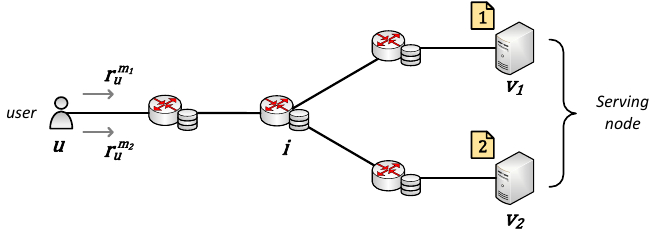
Figure 2. Example of caching content with different popularity (residual